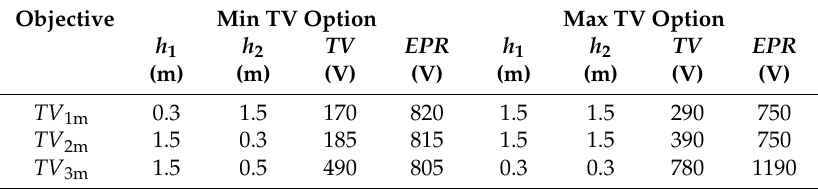
Figure 5. TV profiles along x direction for HoL model ρ 1 = 500 Ω m, ρ 2 = 100 Ω m, D 1 = 2 m, D 2 = 4 m, h 1 Table 3. Sensitivity analysis results for ρ 1 = 500 Ω m, ρ 2 = 100 Ω m, H = 2 m, D 2 = 4 m, D 1 = 3 m. = 0.3 m; ( a ) surface layer thickness H = 2 m; and, ( b ) Surface layer thickness H = 1 m.